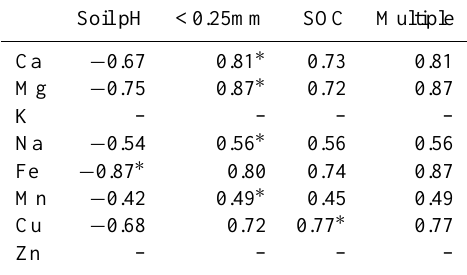
Figure 4. Soil available micronutrients of available Fe (a) , Mn (b) , Cu (c) , and Zn (d) for three soil depths in different soil coarseness degrees of 0% sand addition (C0), 10% (C10), 30% (C30), 50% (C50), and 70% (C70). Data represent mean ± SE ( n = 6). Letters indicate significant differences among treatments (lowercase letters) and differences among soil depths when averaging across all treat- ments (capital letters). Bars without letters above denote no signifi- cance is detected among treatments.